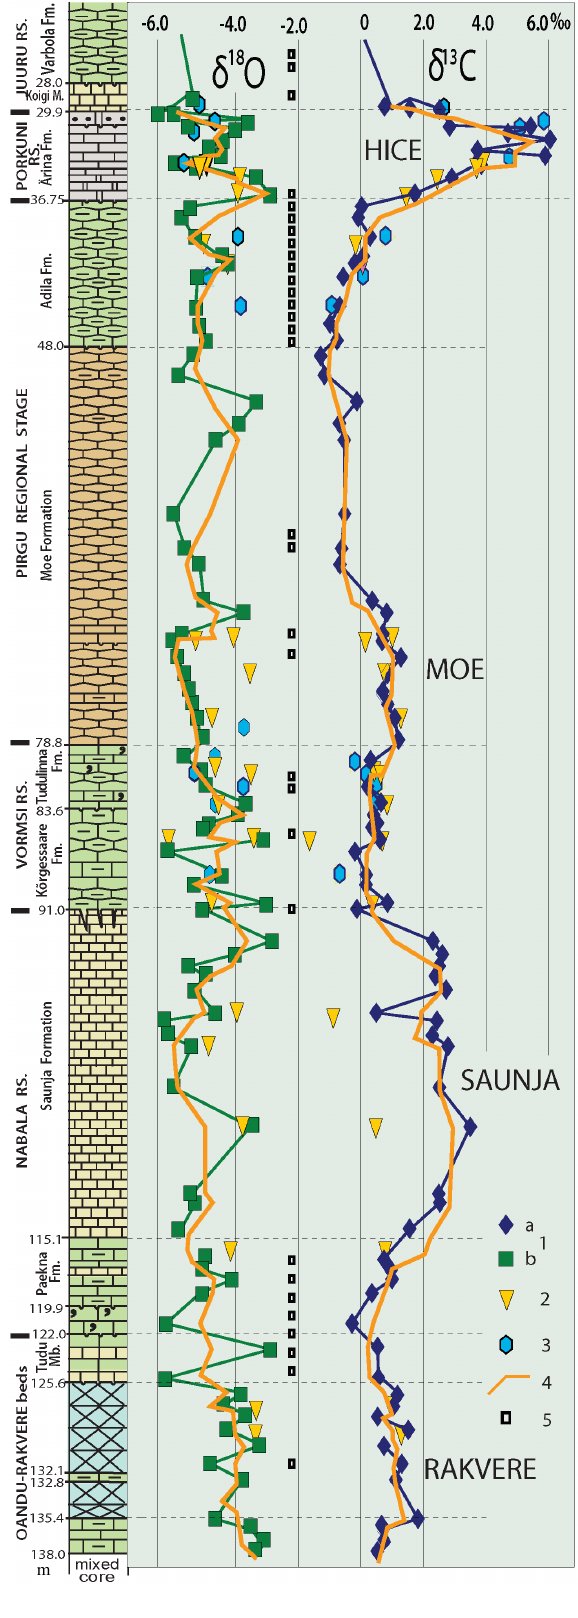
Fig. 4. Comparison of the δ 13 C and δ 18 O data from the whole- rock samples and bioclasts. For data for curves see Table 2 (Annex 3 online). Legend: 1a, whole-rock δ 13 C; 1b, whole-rock δ 18 O; 2, rugose bioclast analyses, δ 13 C and δ 18 O; 3, brachiopod bioclast, the same; 4, yellow line – δ 13 C carb and δ 18 O carb running three-point means; 5, levels with discontinuity surfaces. For lithologies see Fig. 3. Colours are illustrative: light green shows different wackestones, darker green more argillaceous rock, yellow micrite; other colours are unit-specific.